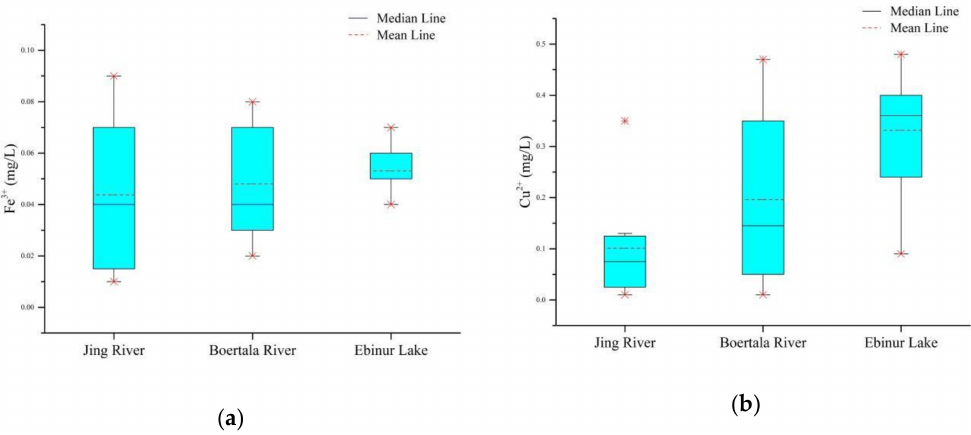
Figure 5. Box plots of ( a ) Fe and ( b ) Cu